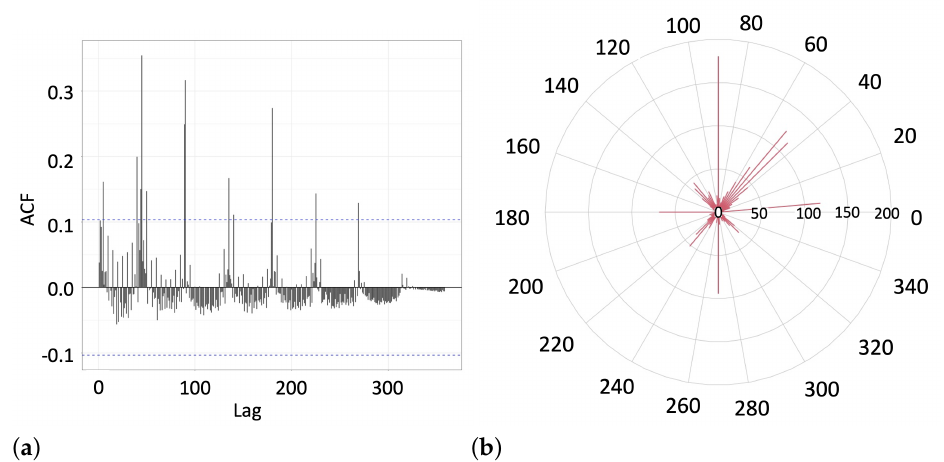
Figure 5. ( a ) The autocorrelation function (10) of the angle lags between the sequential lines observed in Group 1 shows peaks at the lag multiple of 45 ◦ . The dashed horizontal lines mark the level of statistically significant correlations. ( b ) The radial histogram (not normalized) represents the approximation for a kernel density estimation of the line angles drawn in particular directions in Group